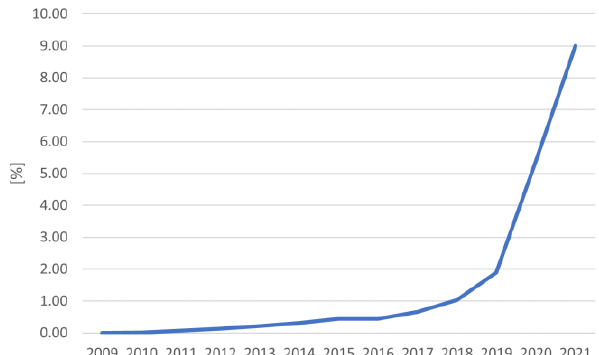
Figure 2. Dynamics of new registered electric vehicle passenger vehicles as a percentage of the total number of registrations at the European level (source